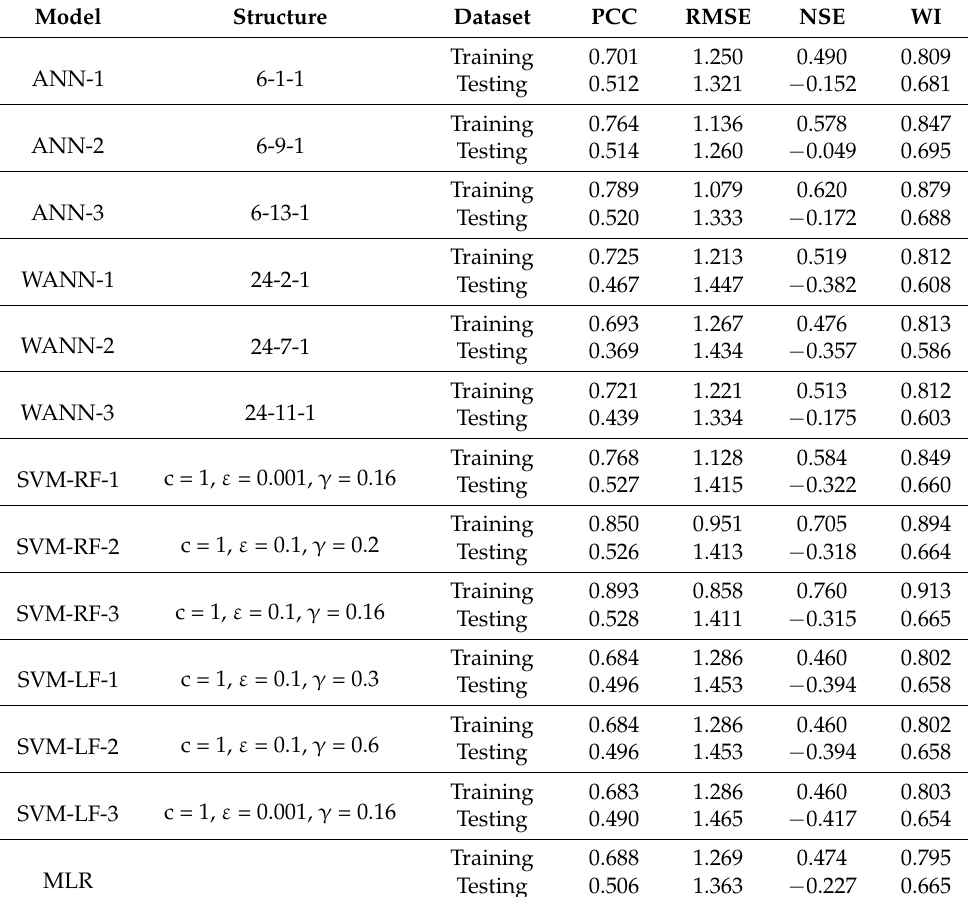
Table 6. Results for ANN, WANN, SVM-RF, SVM-LF, and M.L.R. during the training and testing period for Scenario 3 (80–20: